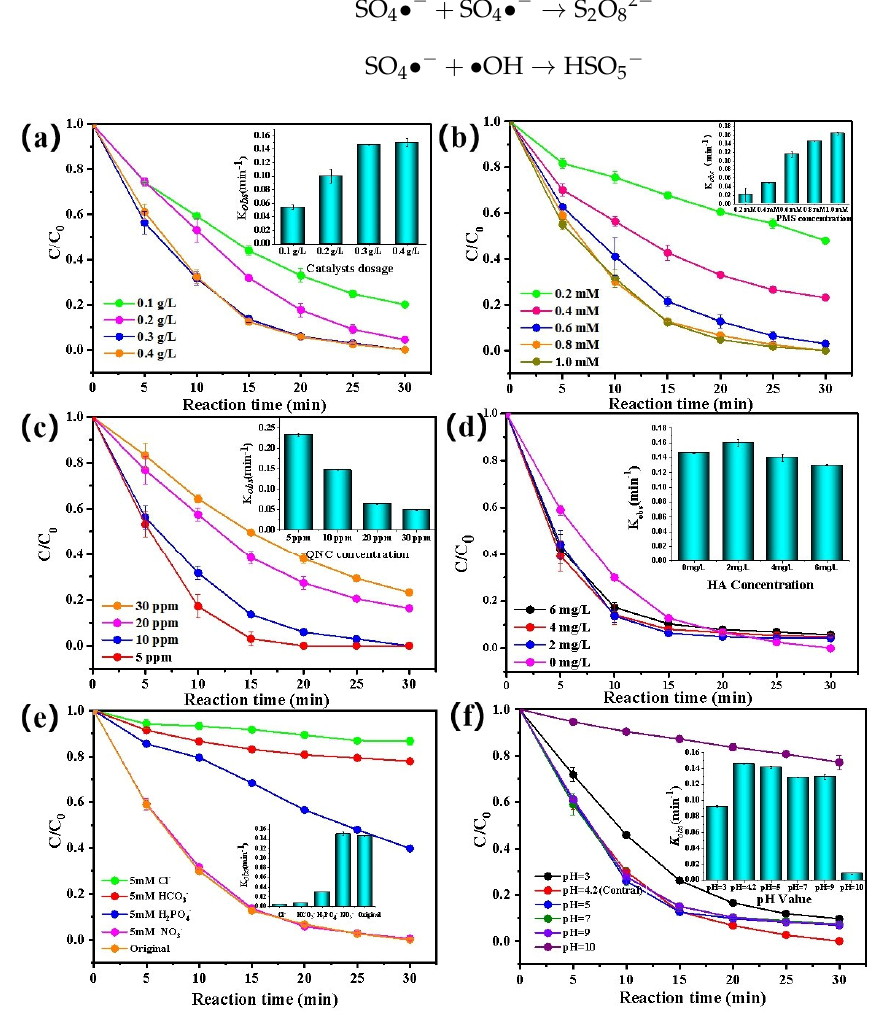
Figure 4. Effects of catalyst dosage ( a ), concentration of PMS ( b ), initial QNC concentration ( c ), HA ( d ), inorganic anions ( e ), and initial pH ( f ) in E/Fe–N–BC/PMS system. Reaction condition: [QNC] = 10 mg·L − 1 , [catalyst] = 0.3 g·L − 1 , [PMS = 0.8 mM], pH = 4.2, T = 25 ± 1